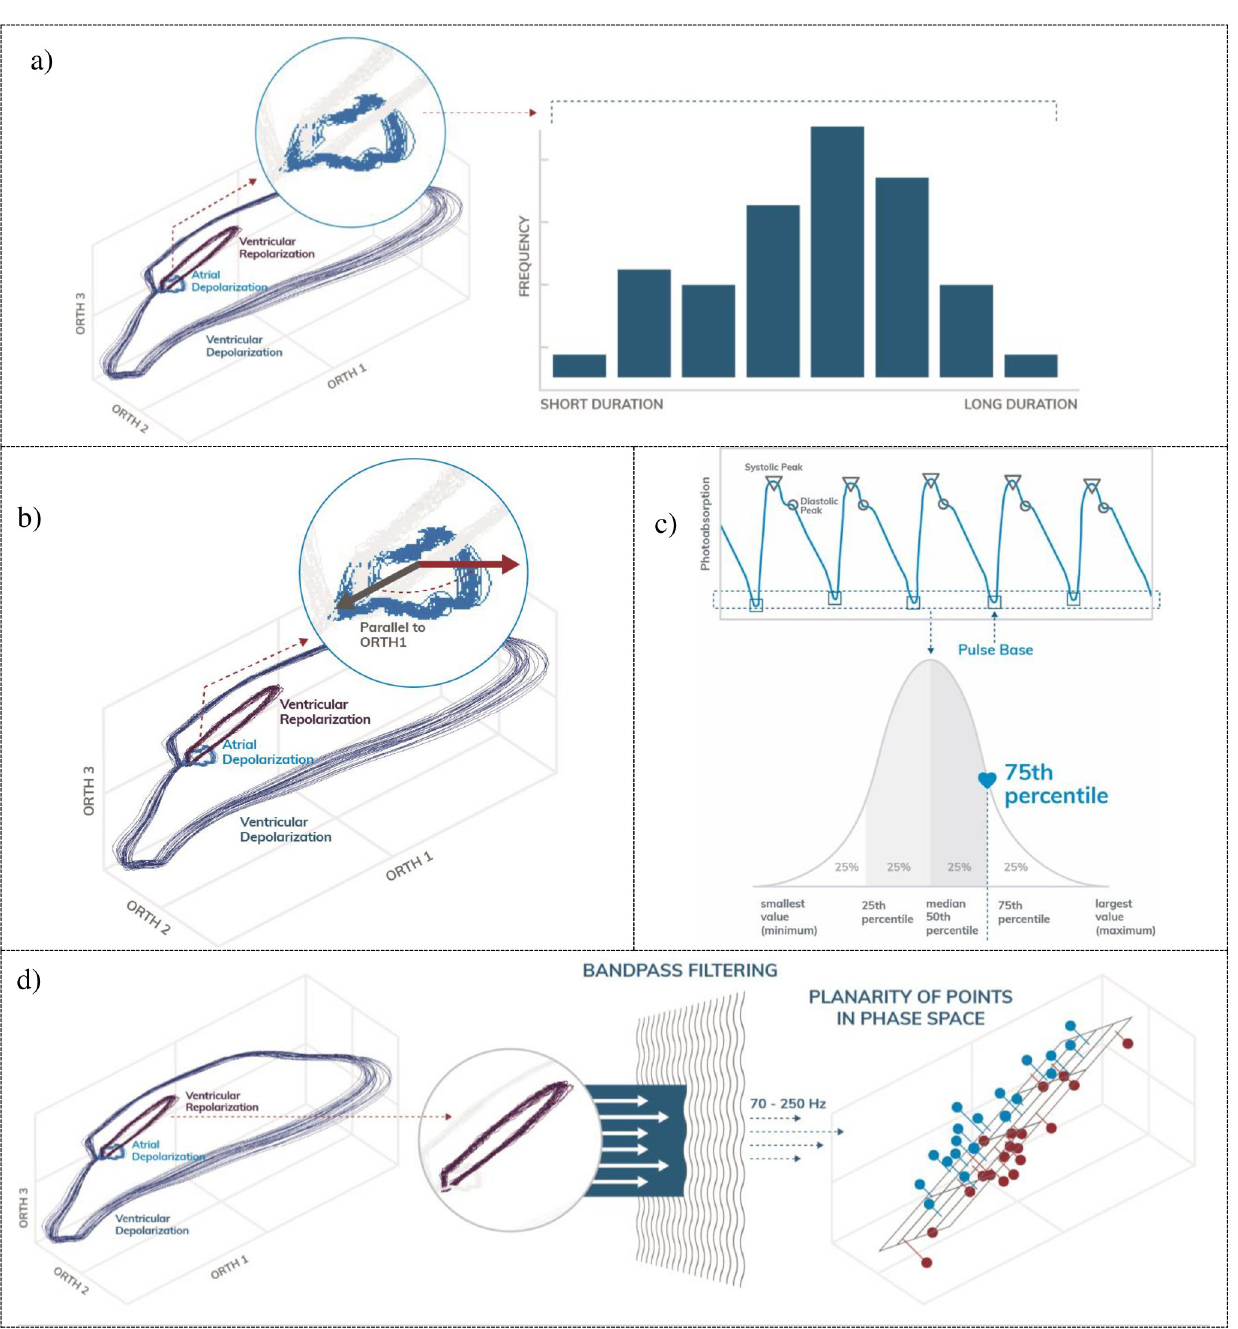
Fig 3. Exemplar features. a) the variation in the atrial depolarization duration is a feature extracted from the OVG signal in the time domain, b) quantification of the atrial depolarization vector in phase space, c) quantification of PPG pulse base amplitude and d) ventricular repolarization in band- pass filtered phase